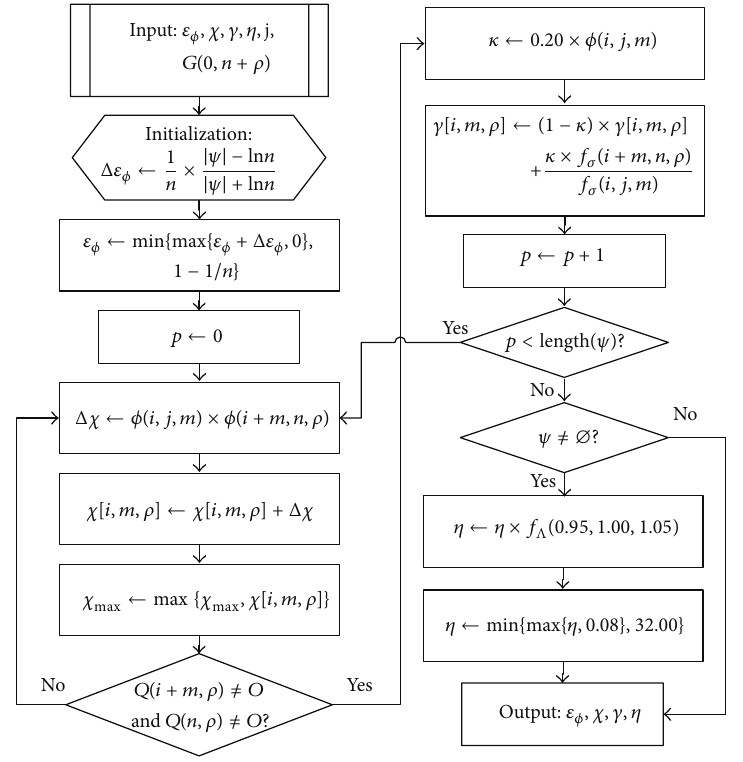
Figure 2: Evolution algorithm flow chart.